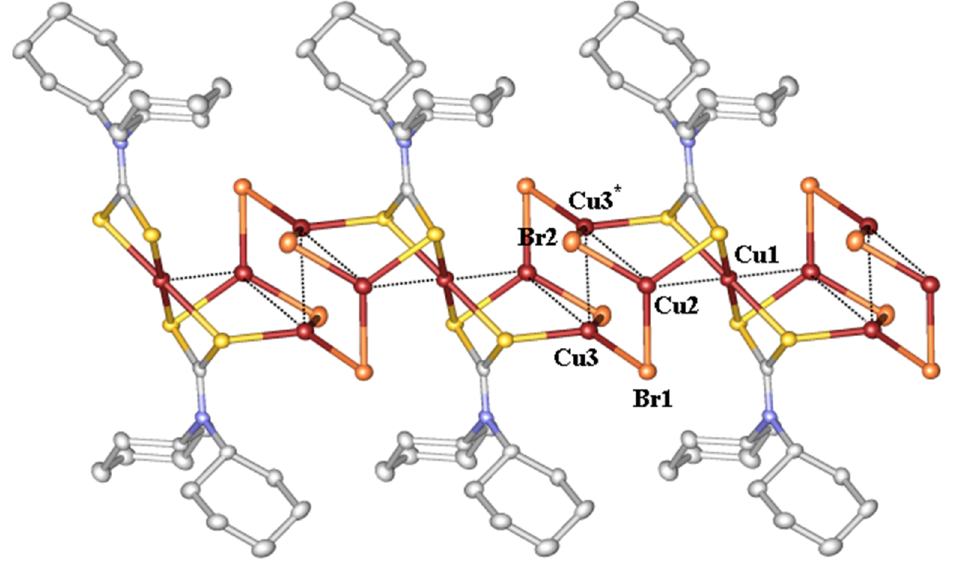
Figure 1. Crystal structure of the infinite 1D chain of 1 . Color code: Cu, red-brown; Br, orange; S, yellow; C, white; N, blue. H atoms are omitted. Symmetry code: * − X + 1, − Y + 1, − Z